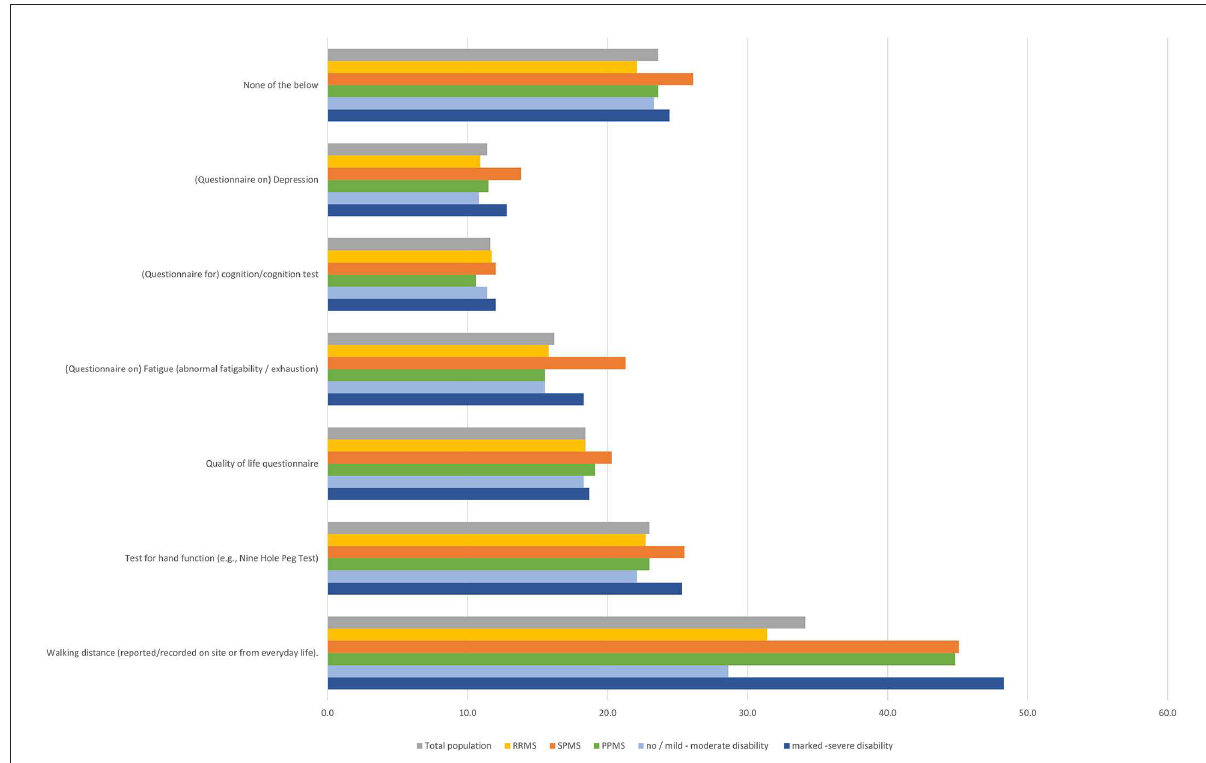
FIGURE7 Regular examinations during visits at neurologist (total population, by subtype, by disease